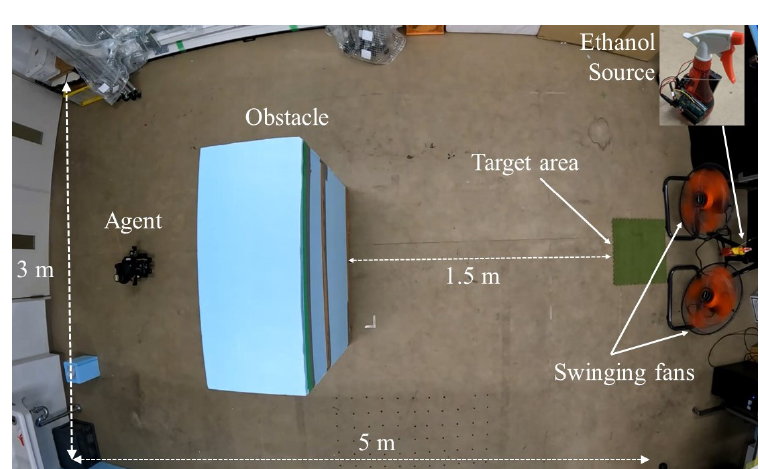
Figure 15. Setup of the experimental